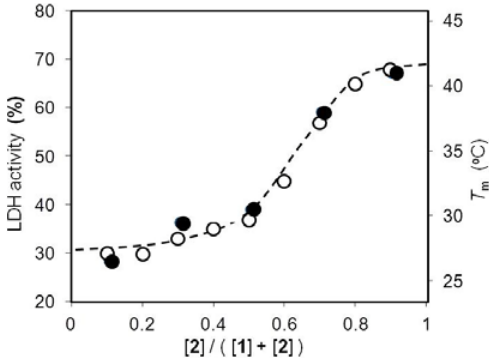
Figure 4. Correlations of lipid molar fraction with LDH activity (open circle) and phase transition temperature (closed) of the bio-inspired molecular device in HEPES buffer (10 mM) at pH 7.0 and 35 °C. Concentrations in mM: [ 1 ]+[ 2 ], 1.0; [DMPE], 0.05; [PLP], 0.02; [LDH], 2.8 × 10 −6 ; [NADH], 0.25; [pyruvate], 0.50; and [Cu 2+ ], 4.0 × 10 −3